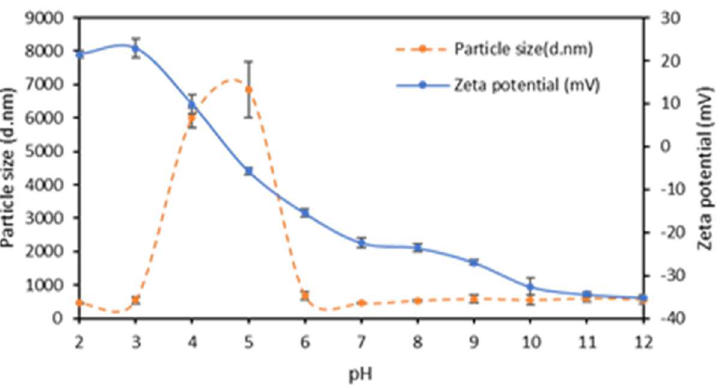
Figure 2. Zeta potential and particle size detected during titration of argan seed protein concentrate. Further experimental details are given in the text. Table 1. Zeta potential, Z-average, and polydispersity index values of film-forming solutions contain- ing increasing amounts of argan seed protein concentrate (ASPC) and glycerol (GLY). Different small letters (a–g) indicate significant differences among the values reported in each column ( p < 0.05). Further experimental details are given in the